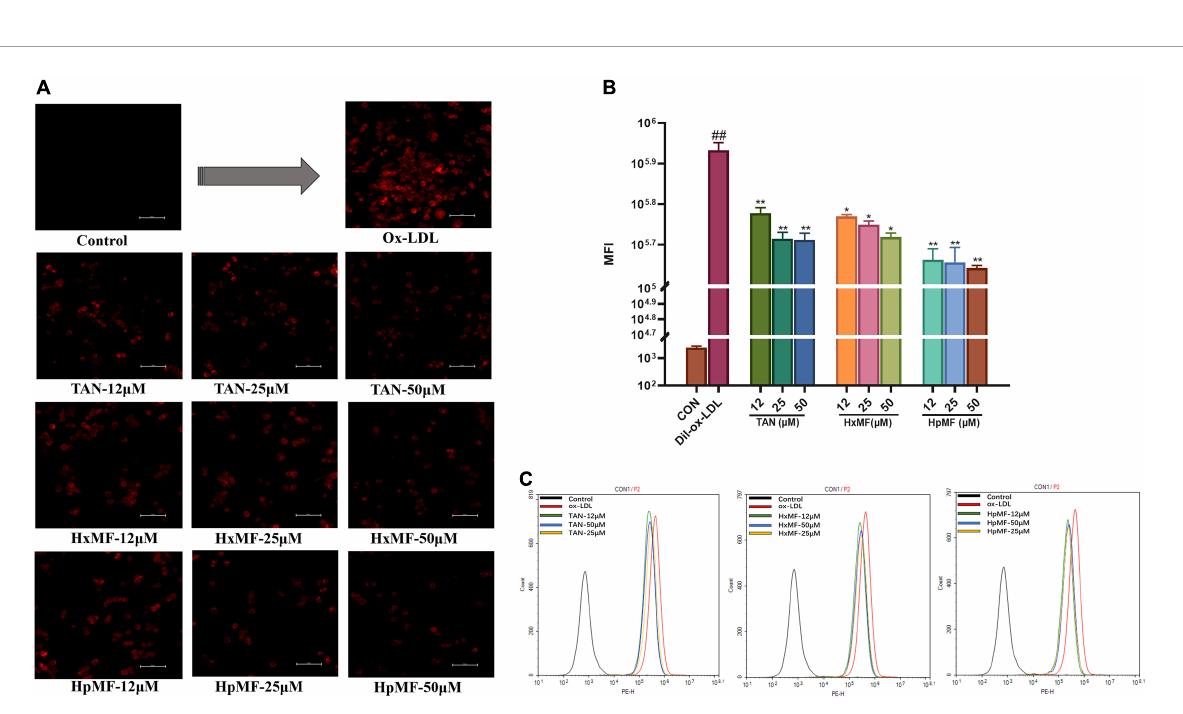
FIGURE4 Effects of TAN, HxMF, and HpMF on Dil-ox-LDL uptake by fluorescence microscope (A) and flow cytometry (B,C) . All experiments were run in triplicate and data showed mean ± SD. ## p < 0.01 compared with the control group, * p < 0.05 and ** p < 0.01 compared with the ox-LDL